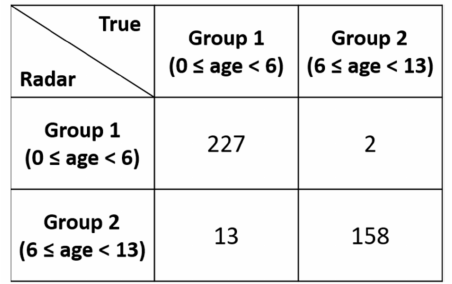
Figure 10. Confusion matrix of the 2 age-group